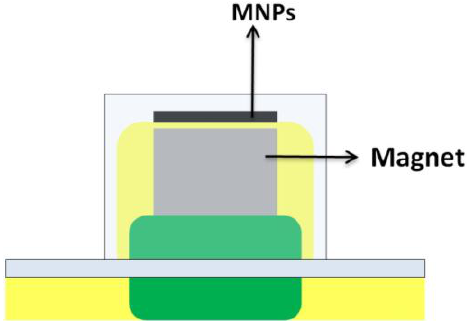
Figure 8. Device for microextraction of magnetically confined hydrophobic nanoparticles. MNPs, magnetic nanoparticles.